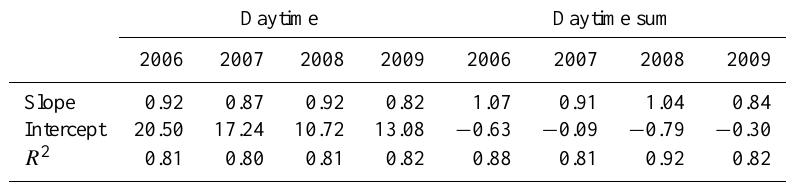
Table 2. Energy balance closure statistics using half-hourly and daytime totals during growing seasons from 2006 to 2009.